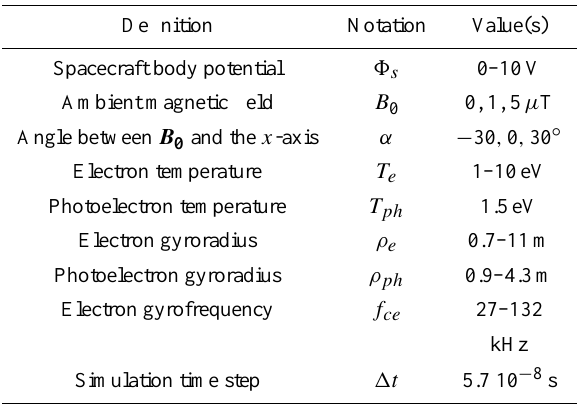
Table 1. List and values of numerical parameters used in the simu-